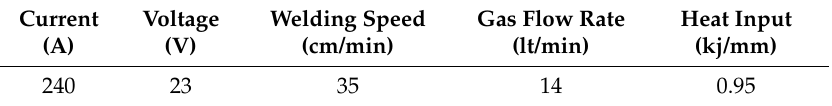
Table 2. The welding parameters used in the submerged arc welding